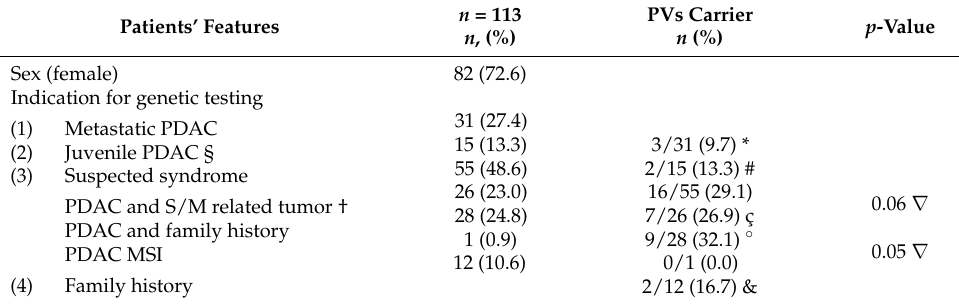
Table 2. Clinical features of the included patients and statistical analysis using Fisher’s exact test of mutational